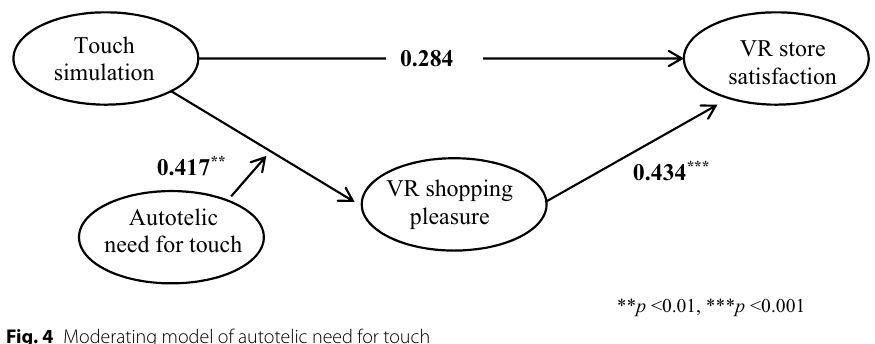
Fig. 4 Moderating model of autotelic need for touch